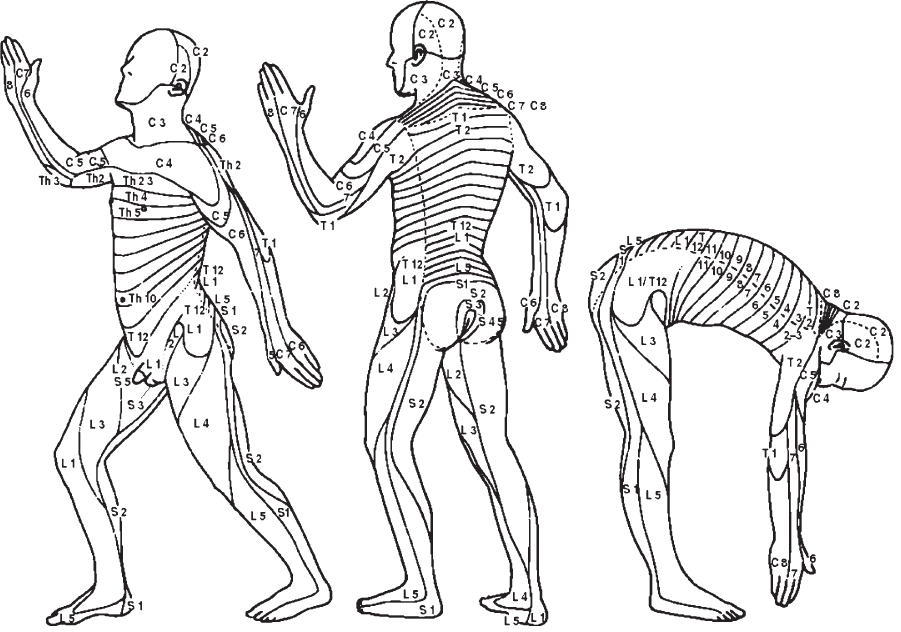
Fig. 4. Levels of spinal cord injury. In our case, patients with spinal cord injuries from C3 (more serious) to C8 (less serious) are